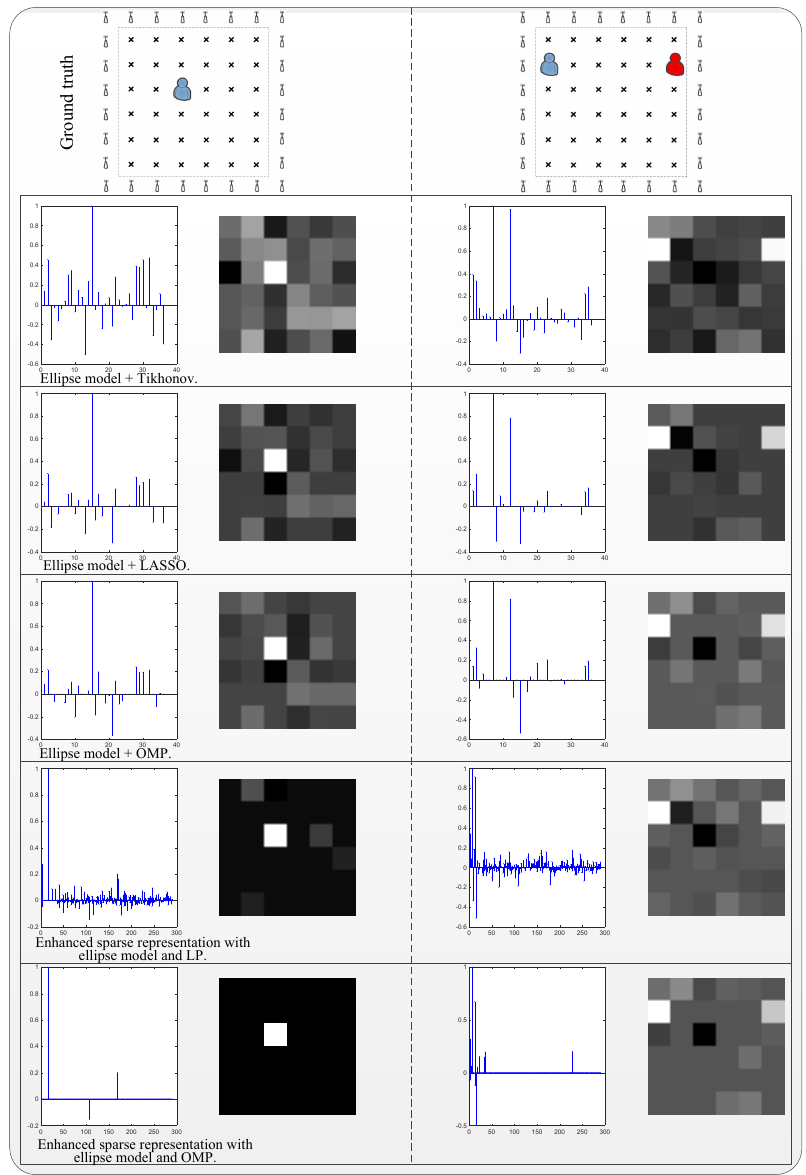
Figure 2. Imaging comparison of localizations using different methods in the outdoor scenario. LASSO: least absolute shrinkage and selection operator; LP: linear programming; OMP: orthogonal matching